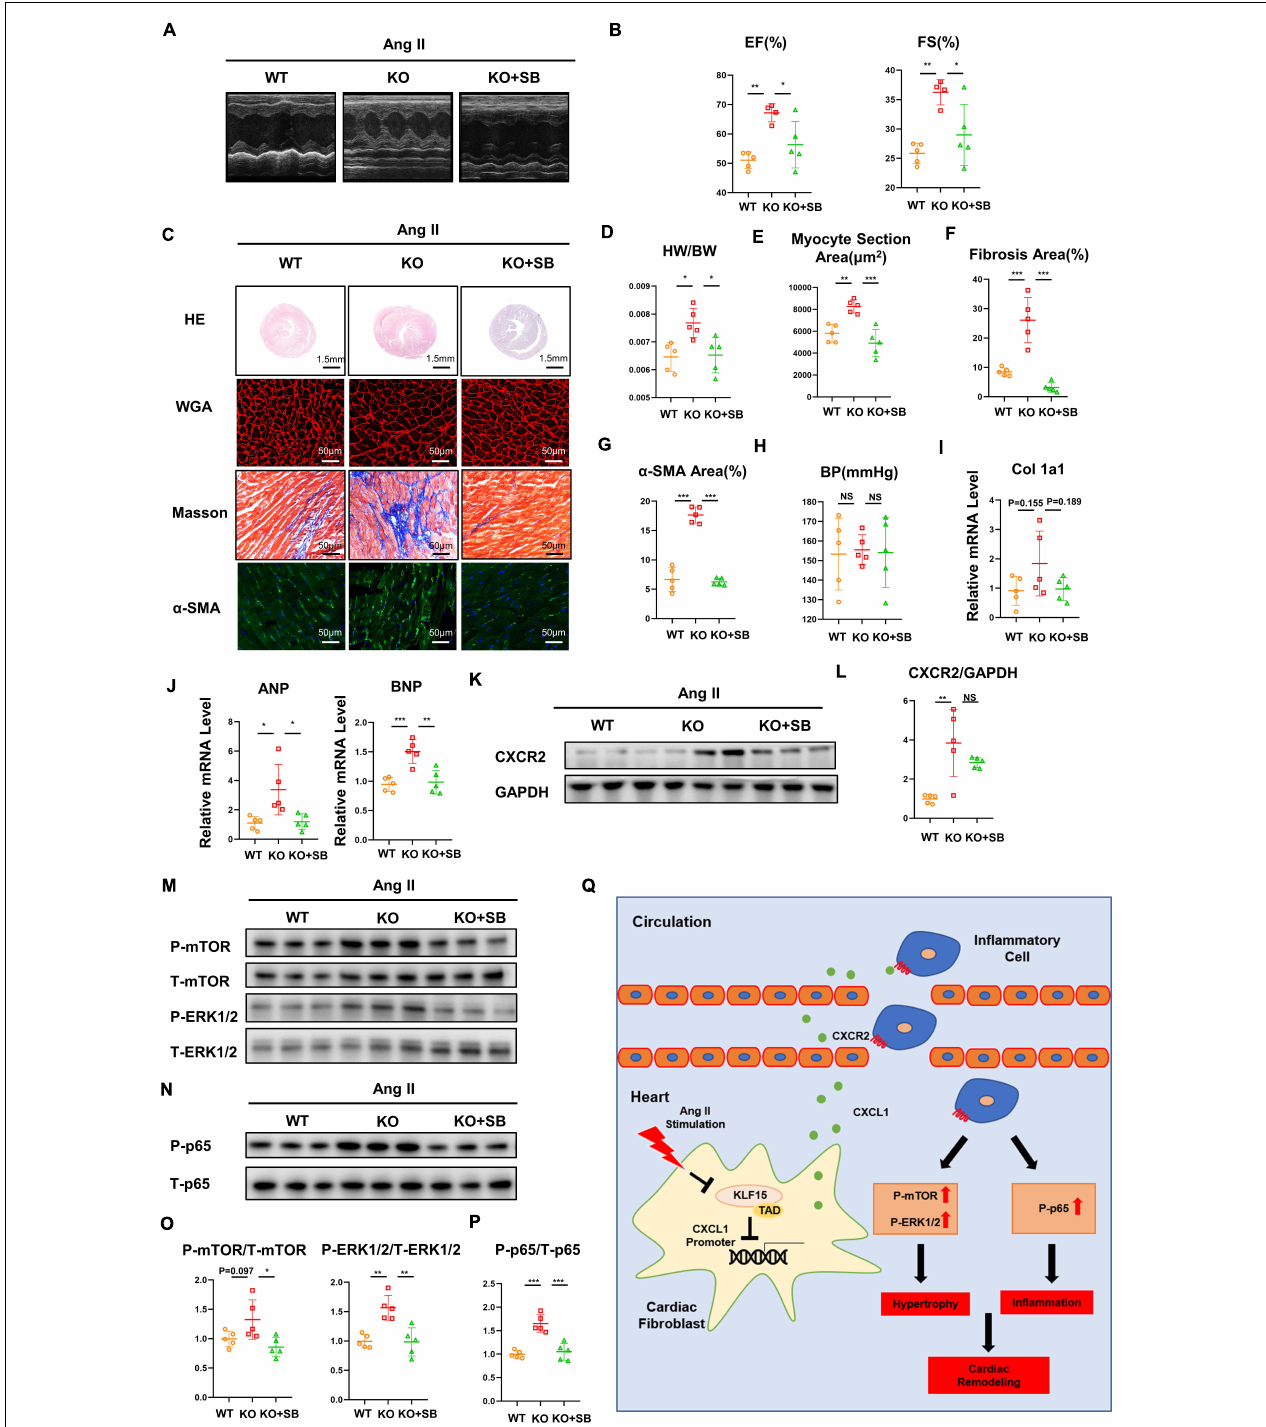
FIGURE 6 | Inhibition of CXCR2 rescued KLF15 KO-aggravated cardiac remodeling. KLF15 KO mice was i.p. injected with SB265610 (2 mg/kg/day) and infused with Ang II for 14 days. WT and KLF15 KO mice only infused with Ang II were used as control. (A) M-mode echocardiography of left ventricular chamber. (B) Measurement of ejection fraction (EF%) and fractional shortening (FS%). (C) Representative heart size, WGA stain, Masson stain and α -SMA immunofluorescence image. (D) Heart weight/body weight ratio. (E) Quantification of myocyte section area. (F) Quantification of fibrotic area revealed by Masson staining. (G) Quantification of α -SMA positive area. (H) Statistical analysis of blood pressure. (I,J) qPCR analysis of mRNA levels of Collagen 1a1, ANP and BNP. (K,L) Western Blot and quantification analysis of CXCR2 /GAPDH. (M–P) Western Blot and quantification analysis of P-mTOR/T-mTOR, P-ERK1/2/T-ERK1/2 and P-p65/T-p65 of mice hearts. * P < 0.05, ** P < 0.01, and *** P < 0.001. (Q) A working model describing that KLF15 in cardiac fibroblasts negatively regulates CXCL1/CXCR2 axis-mediated inflammatory response and subsequent cardiac remodeling in hypertension.